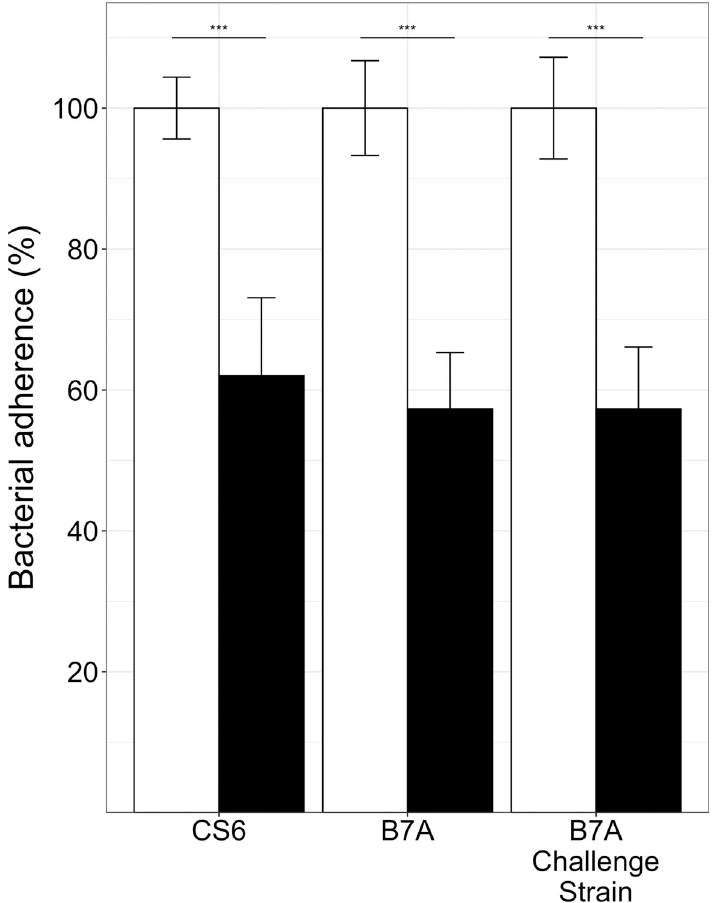
Fig 5. Rabbit serum antibody adherence inhibition activity against ETEC CS6 (2423 ETP98066) or B7A strains. CS6 and B7A bacteria adherent to Caco-2 cells (CFUs, in %) after incubation with rabbit serum samples from the control group ( □ ) or the group IM vaccinated with CFA/I/II/IV MEFA protein ( ■ ). Boxes and bars represented means and standard deviations, ��� indicates a p value of < 0.001.